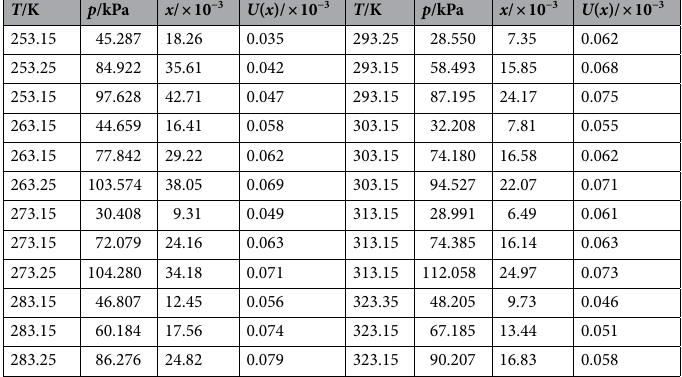
Table 3. Solubility (mole fraction) and associated uncertainty of CO 2 in RP5.